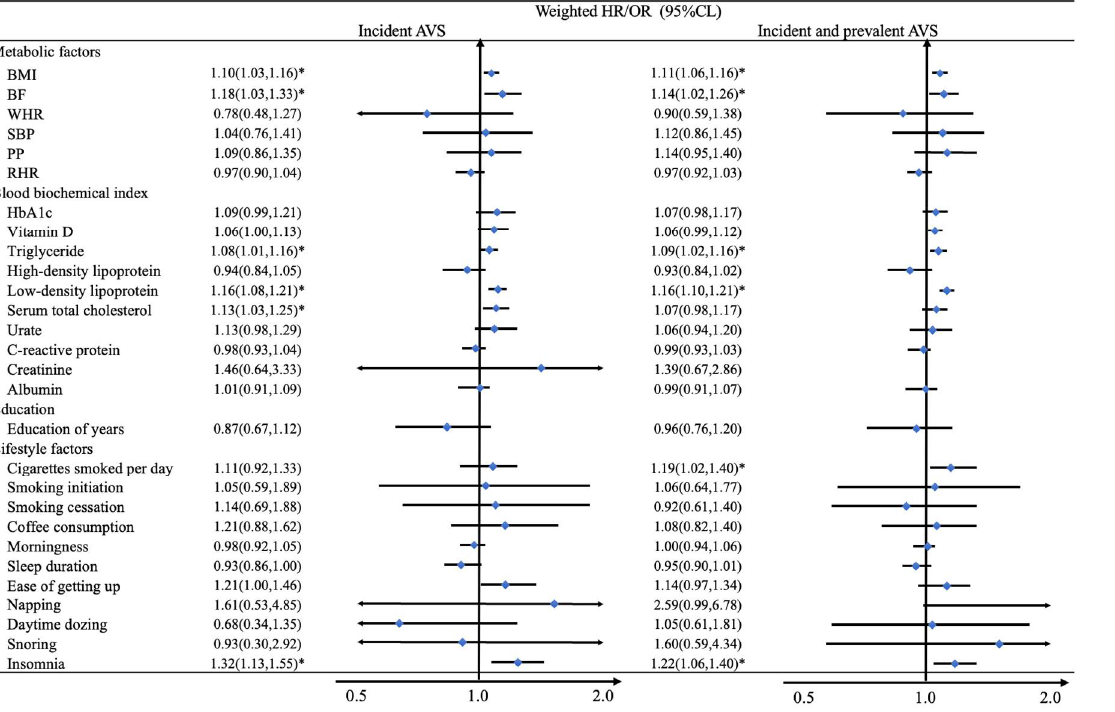
Figure 4. Mendelian randomization analysis between 28 modifiable risk GRS and AVS phenotypes. The MR analysis was adjusted by sex, age, the first 10 genetic principal components, and genotyping chip. The Cox model was used in patients with incident AVS, and the logistic model was used in patients with the incident and prevalent AVS patients. The weighted GRSs used for prediction. * p-value less than 0.0018 (after adjusted by Bonferroni correction).